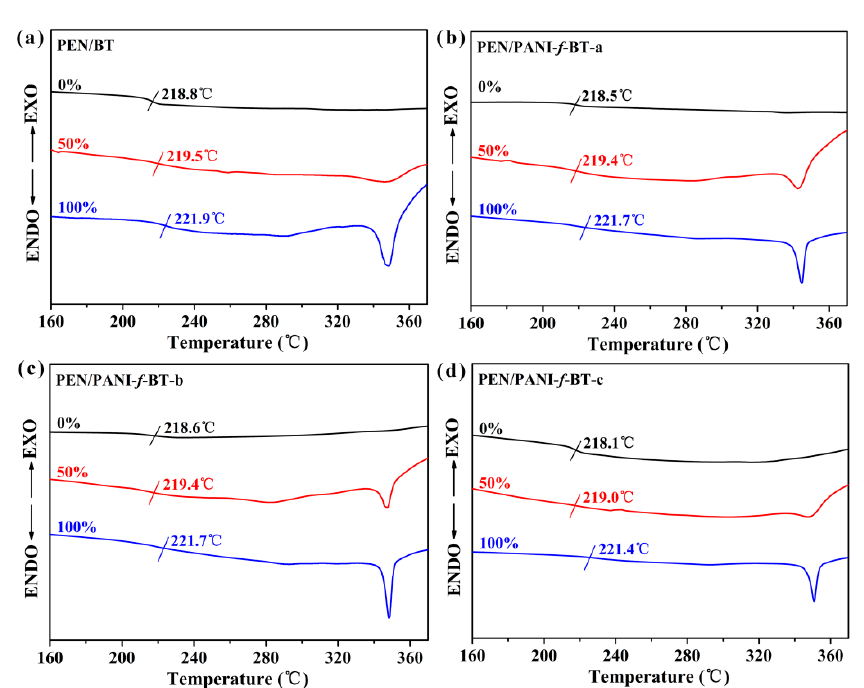
Figure 6. The differential scanning calorimetry (DSC) curves of nanocomposites with different Figure 6. The di ff erential scanning calorimetry (DSC) curves of nanocomposites with di ff erent stretching stretching ratios: ( a ) PEN/BT; ( b ) PEN/PANI- f -BT-a; ( c ) PEN/PANI- f -BT-b; ( d ) PEN/PANI- f -BT-c. ratios: ( a ) PEN / BT; ( b ) PEN / PANI- f -BT-a; ( c ) PEN / PANI- f -BT-b; ( d ) PEN / PANI- f